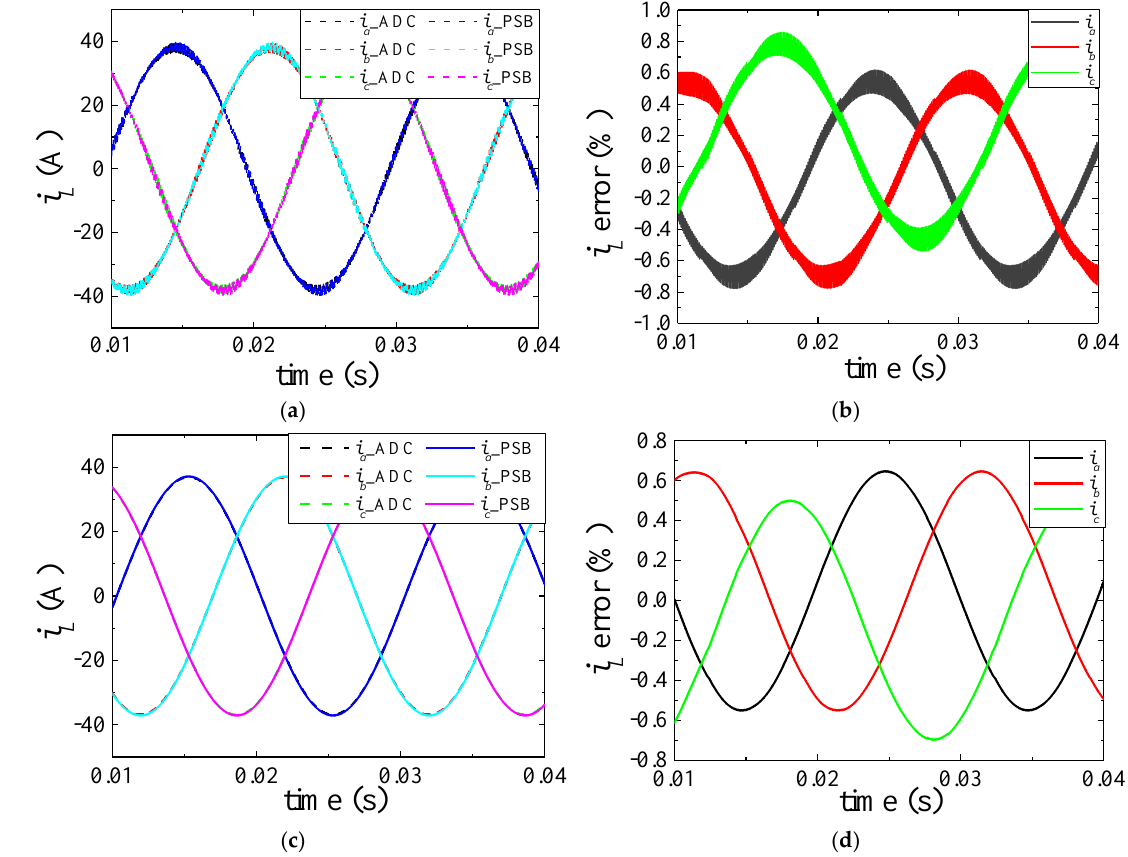
Figure 7. Three-phase current comparison: ( a ) three-phase current of inverter side; ( b ) relative error; ( c )three-phase current of load side; ( d ) relative error.